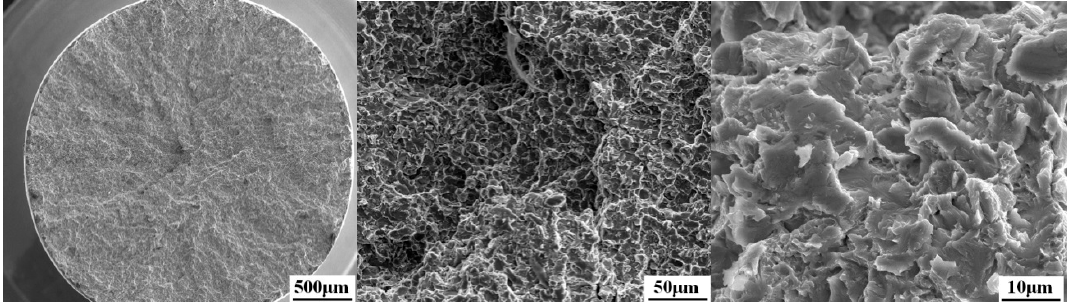
Figure 11. Tensile strength results with heat treatment from 700 °C to 900 °C.